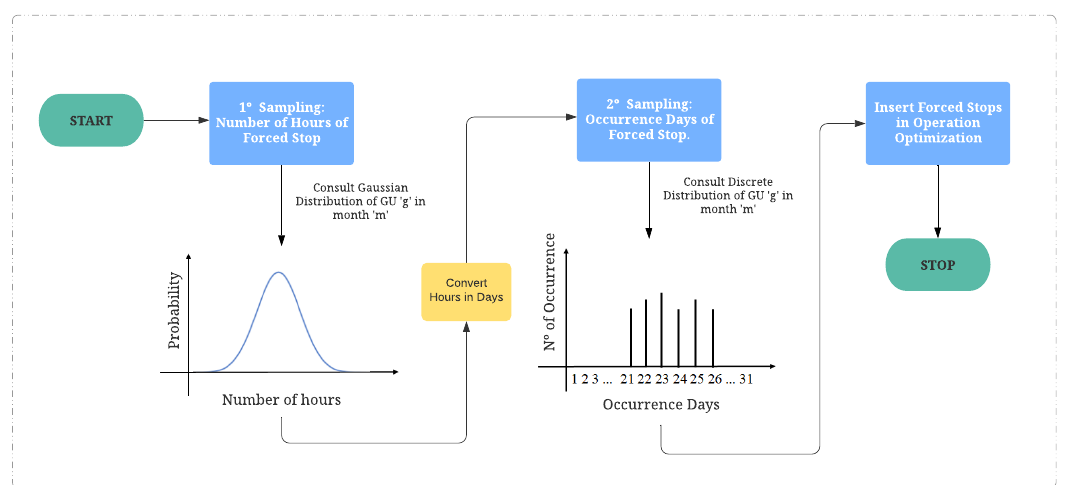
Figure 4. Process for Sampling the Random